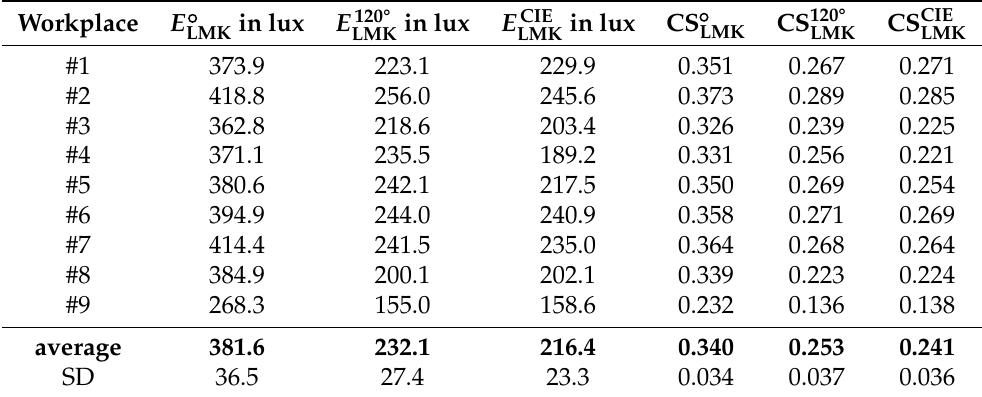
Table 2. Comparison of the illuminance and CS values calculated from the spatially resolved light measurements for the different FOV definitions, i.e., a half-space geometry, an assumed 120° observer, and the FOV definition of CIE S